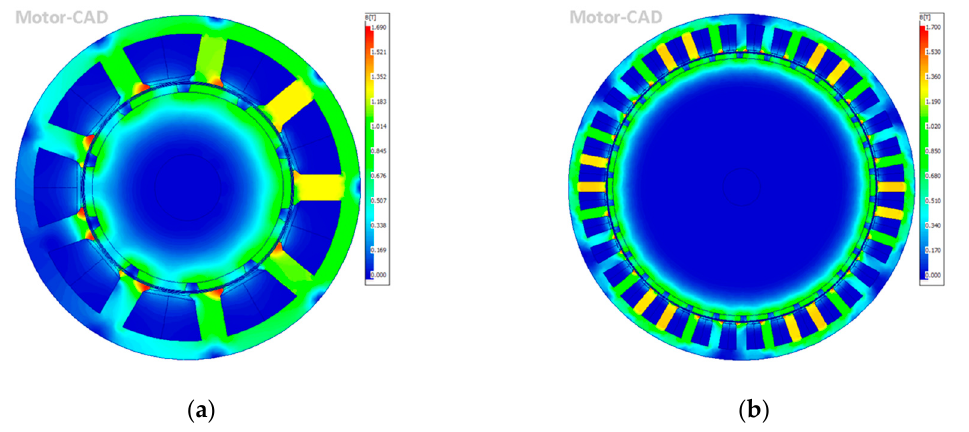
Figure 3. Flux density distribution for a machine with: ( a ) Q = 9, p = 10; ( b ) Q = 36, p = 40.